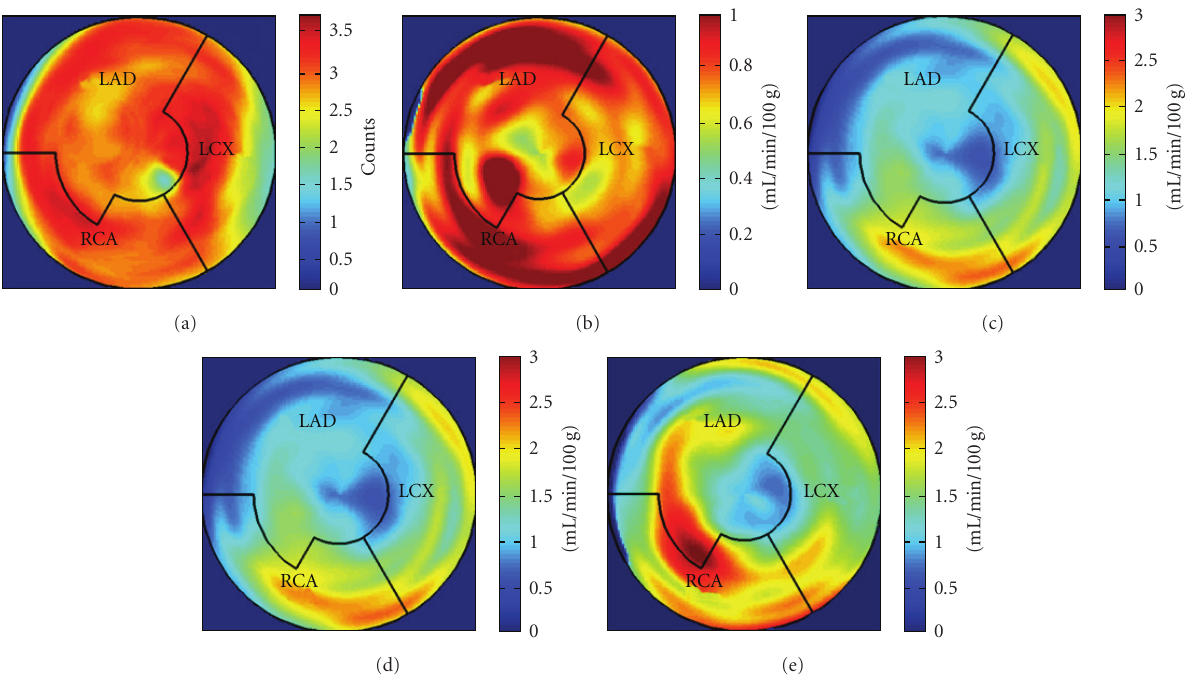
Figure 1: (a)–(e) PET imaging before (a)–(d) and after (e) 18 sessions of ultrasound-guided CSWT focused on the septal and inferior wall in this patient with chronic refractory angina and without a revascularization option. (a) Bulleye map of myocardial viability FDG PET at baseline, showing preserved viability (red). (b) Perfusion at rest as assessed with N-13-ammonia PET with quantitatively normal perfusion values. (c) Perfusion with N-13-ammonia under adenosine stress at baseline revealed severely reduced perfusion values in the anterior and anteroseptal wall, the apical half of the lateral wall and in the apex. (d) and (e) Blownup maps of stress perfusion at baseline (D = C) and followup (e) with improved stress perfusion in parts of the septum and the adjacent inferior